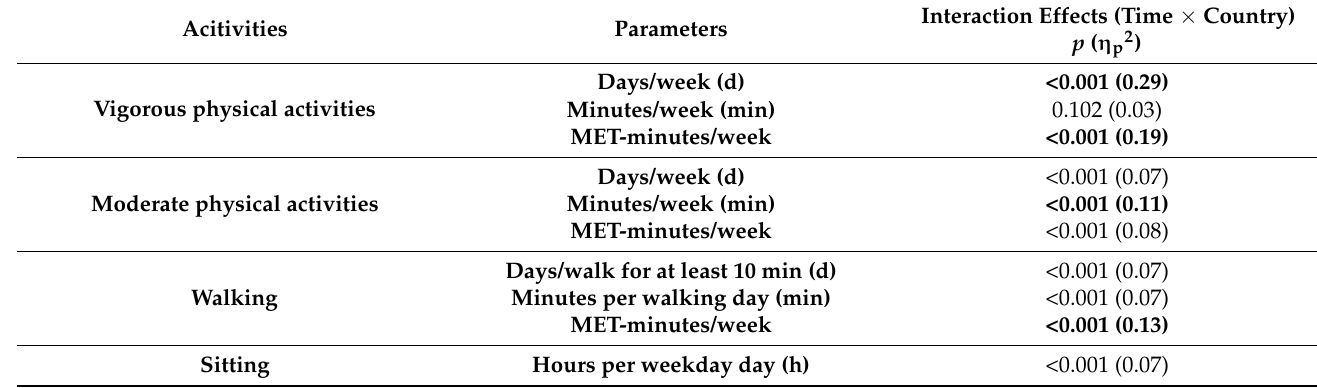
Table 6. Comparison of physical activity parameters between countries before and during confinement. Meaningful interaction effects (criteria: p < 0.05 and η p2 > 0.10) highlighted in